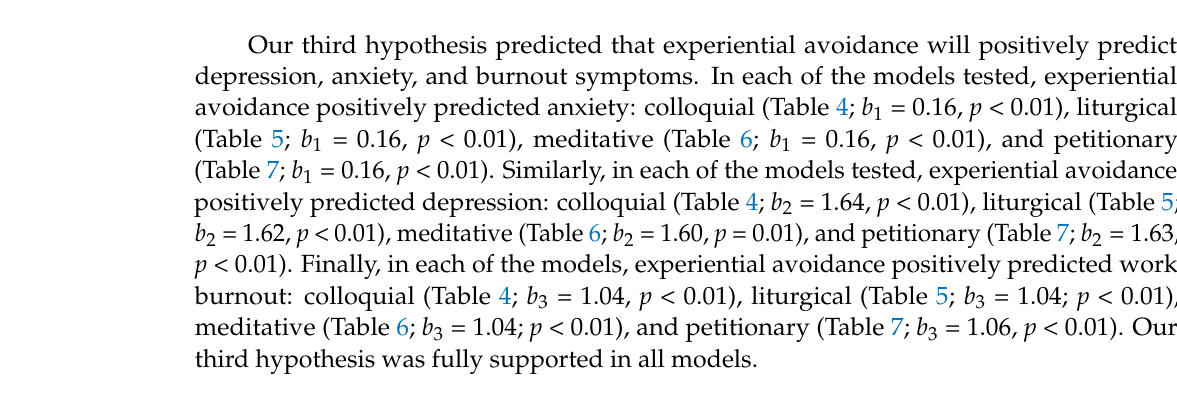
Note. Estimates represented in the table are unstandardized parameter estimates. The corresponding stan- dardized indirect effects predicting dependent outcomes as follows: anxiety = − 0.08, 95% CI [ − 0.13, − 0.03];